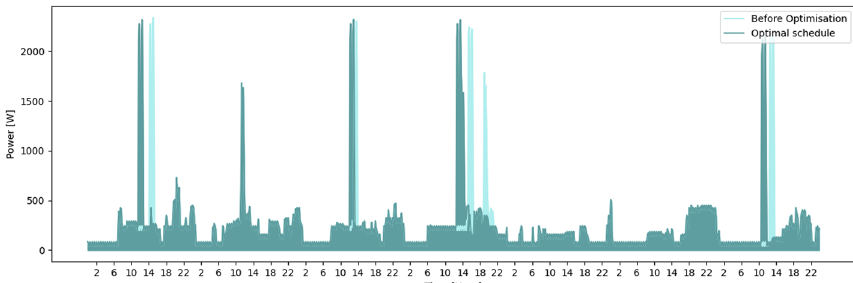
Fig. 13 Example of optimal scheduling for a single household in the Case study 2 for an entire week